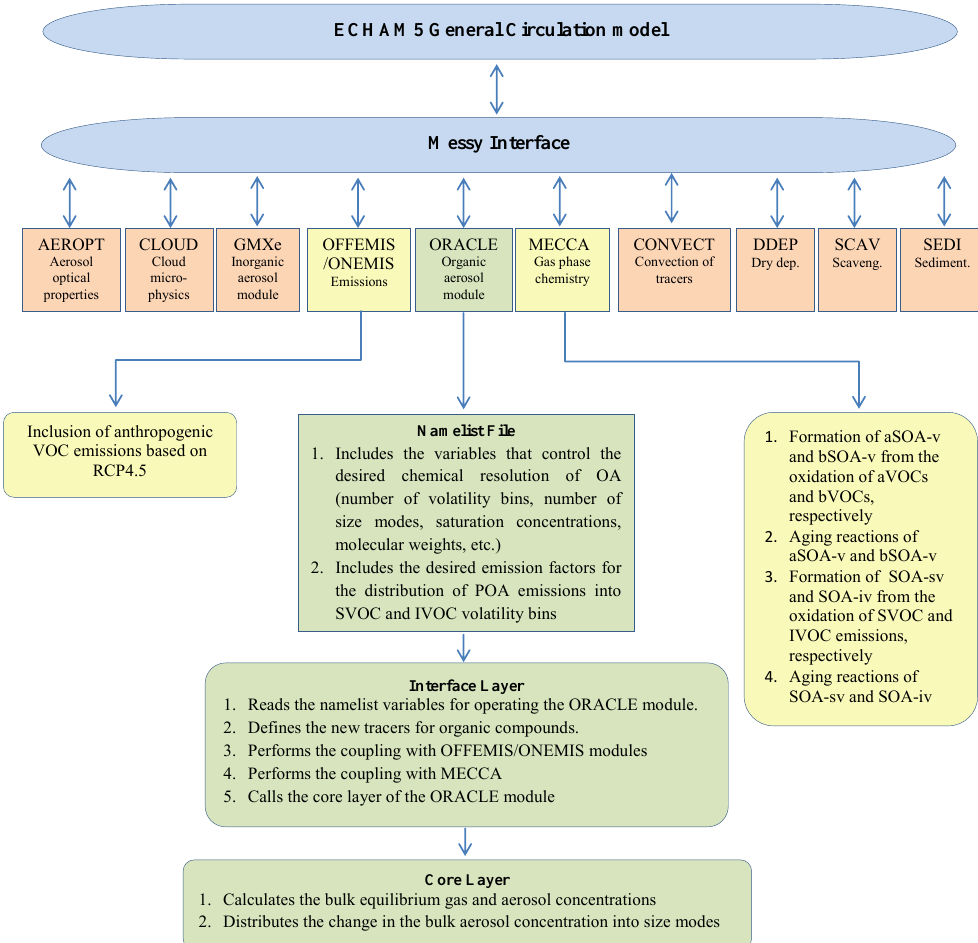
Figure 1. Diagram showing ORACLE as part of the EMAC chemistry–climate Figure 1: Diagram showing ORACLE as part of the EMAC chemistry-climate model.